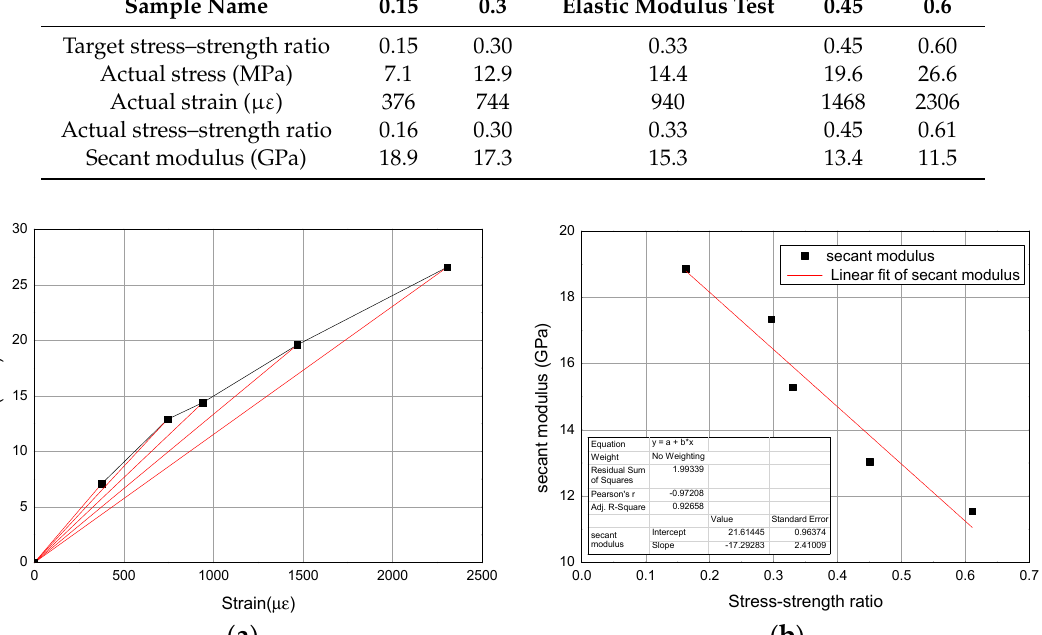
deviation of residual values by adjustment models predicted value minus experimental data value are shown in Table